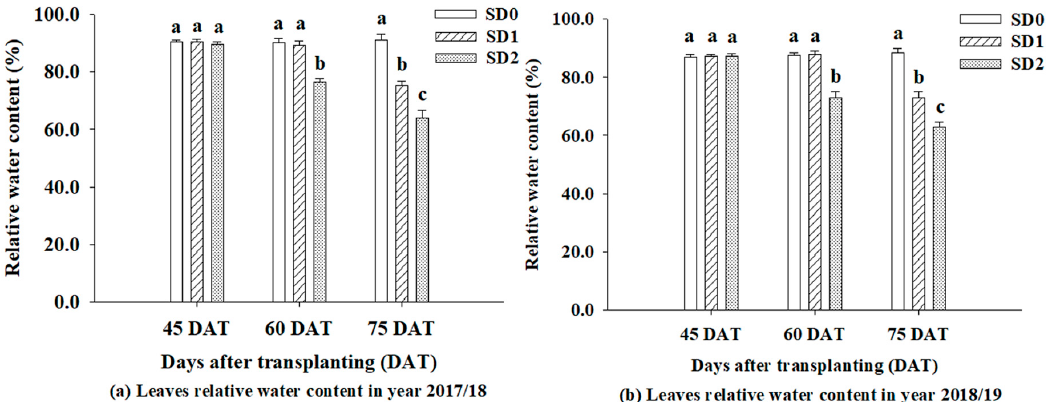
Figure 2. The soil moisture content at 45, 60 and 75 DAT of six JA genotypes grown under three drought durations as SD0 (no drought), SD1 (drought from 60 DAT until harvest) and SD2 (drought from 45 DAT until harvest) at the depths of 30 and 60 cm in years 2017/18 ( a , b ), respectively, and 2018/19 ( c , d ), respectively. Note: Error bars were the standard deviation of the drought duration. The same letters indicated at each drought duration in 2017/18 and 2018/19 were not different for each date by the least significant difference (LSD) at p ≤ 0.05 probability level.